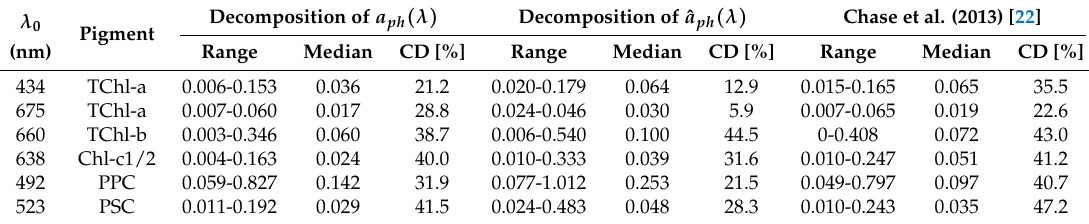
Table 7. The range of values, median and quartile coefficient of dispersion (CD) for the Gaussian decomposition derived pigment-specific absorption coefficient at the corresponding wavelength a ∗ (in m 2 mg − 1 ).